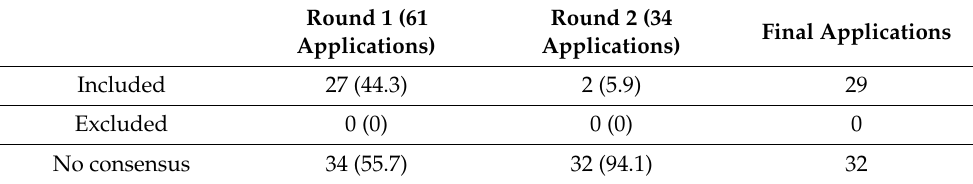
Table 2. Number of POCUS Applications by Delphi Round.